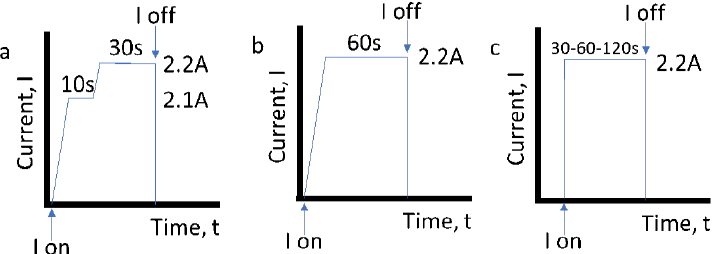
Figure 2. Current–time profiles used in the different experiments: ( a ) intensity gradually increased from 0 to 2.1 A and held 10 s, then risen slowly to 2.2 A and held 30 s; ( b ) intensity gradually increased from 0 to 2.2 A and afterwards held 60 s; ( c ) intensity directly established at 2.2 A and held 30, 60 and 120 s.